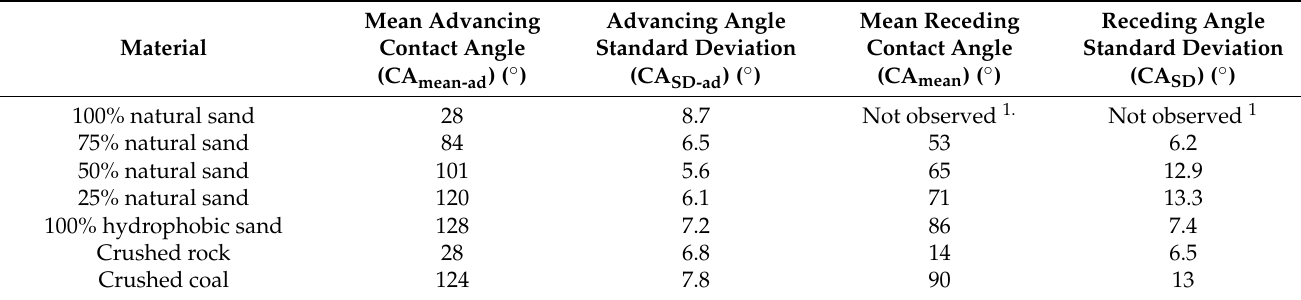
Table 2. Mean contact angles and standard deviation for each material (nine or more measurements performed).